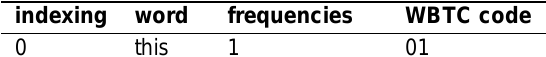
Table 16: Wt for Table